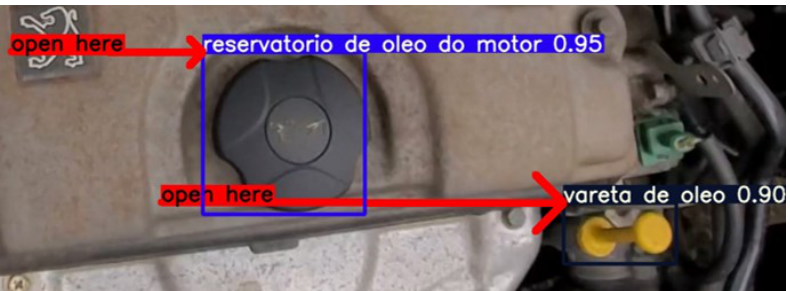
Figure 3. Example of object detection on a test image, where the engine oil reservoir and oil dipstick are detected.